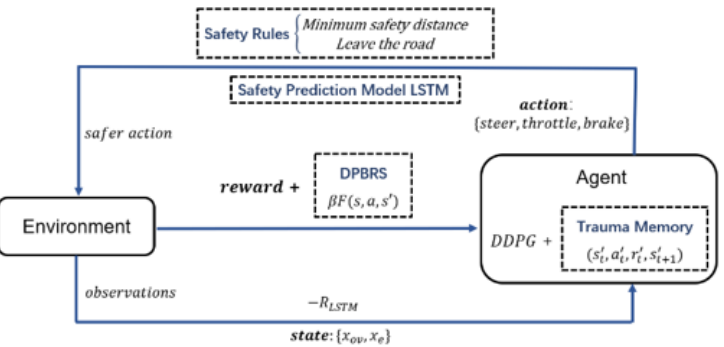
Figure 5. System architecture of the proposed RL algorithm.